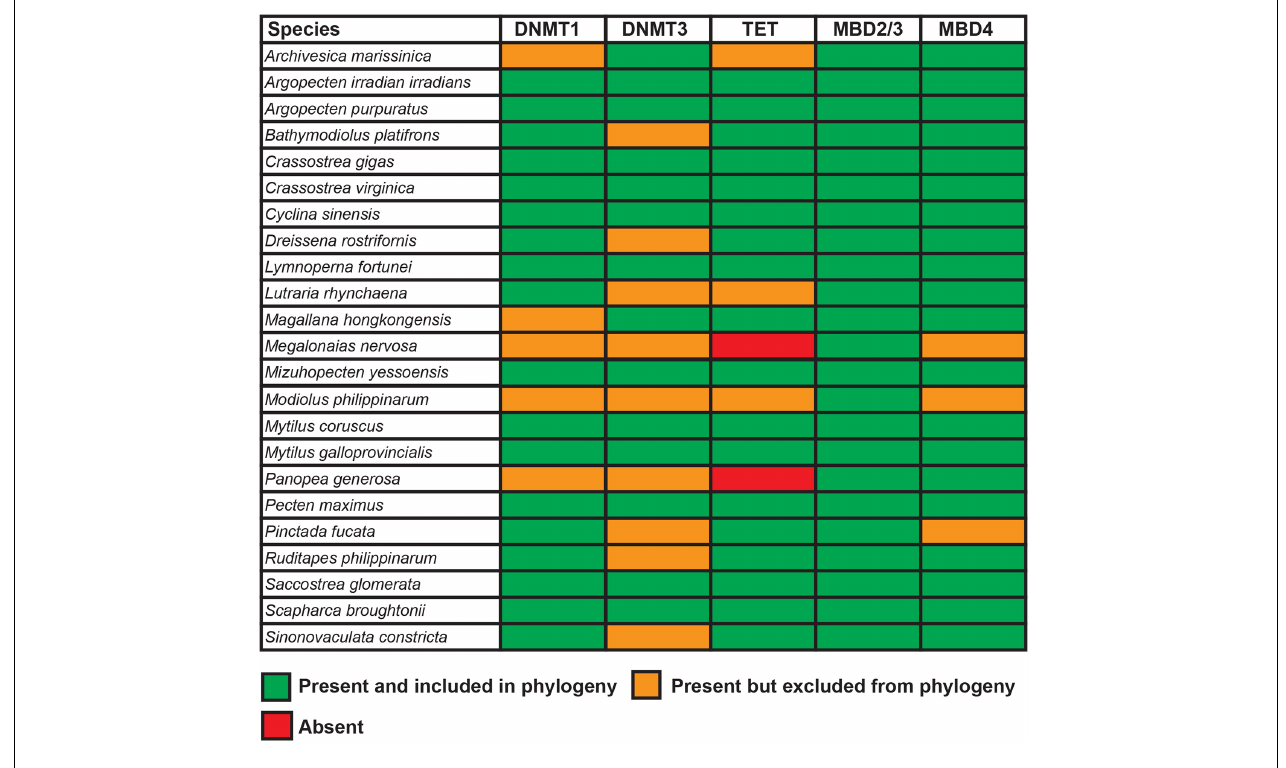
FIGURE 4 | Summary of the genes involved in the DNA methylation machinery found in the 23 bivalve species analyzed in this study.